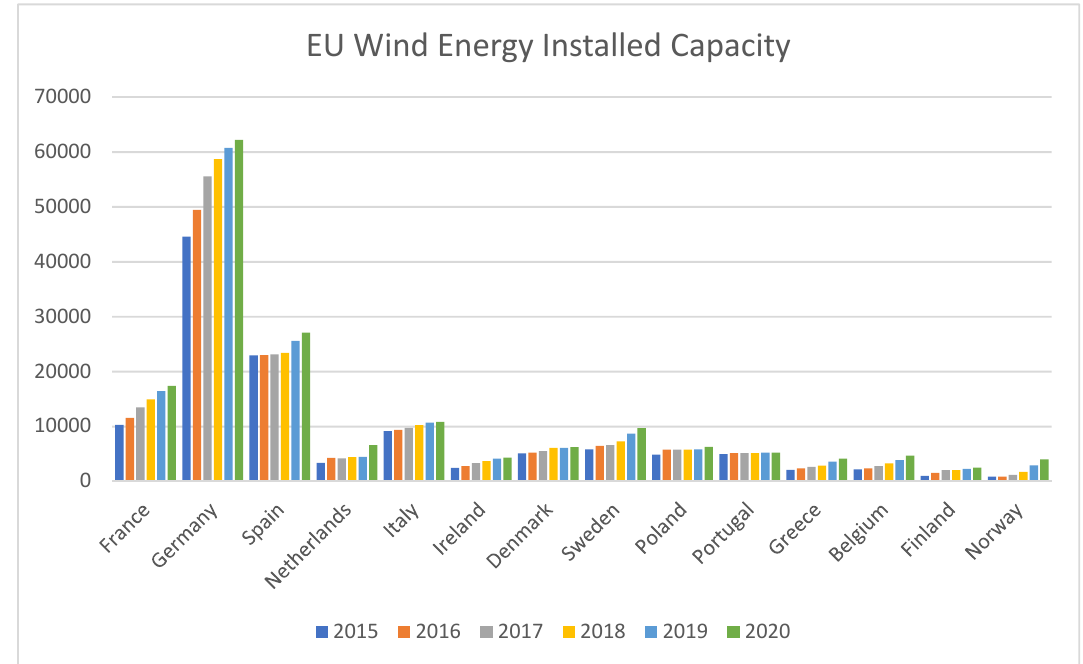
Figure 7. EU wind energy installed capacity 2015–2020 [42,43].